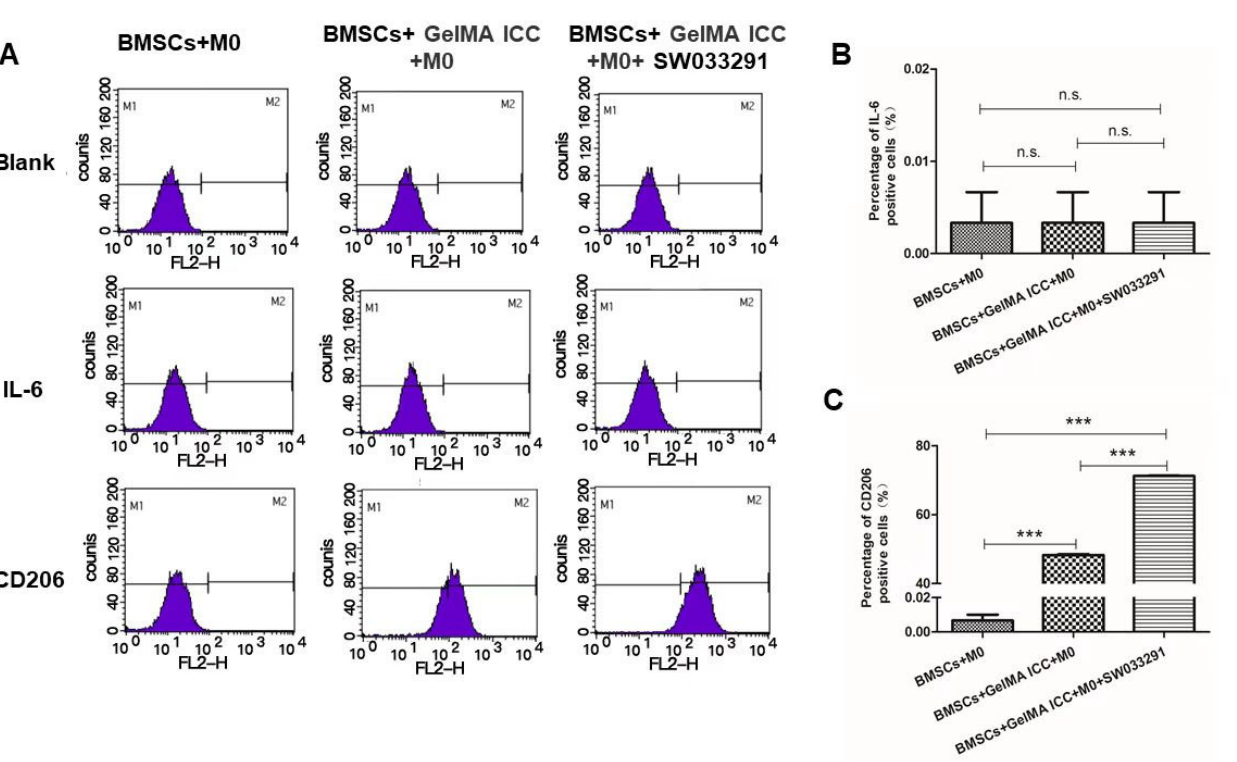
Figure 3. Effect of GelMA ICC with SW033291 on the polarization of macrophages ( A ) Histogram of flow cytometry analysis showing the expressions of markers of macrophages polarization including M1 (IL6) and M2 (CD206) in different groups; ( B ) The percentage of IL-6 and CD206 positive cells (n.s: no significance); ( C ) The percentage of CD206 positive cells. Data represent mean ± standard deviation, n = 3. (*** p < 0.01 vs. the BMSCs + M0 control group).